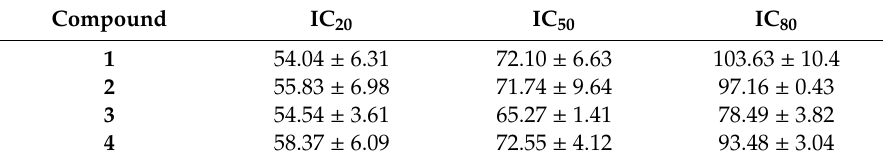
Figure 7. E ff ect of compounds 1 , 2 , 3 , and 4 , on cell proliferation in RAW 264.7 macrophage murine cells, after 72 h of treatment with assayed compounds in a wide range of concentration from 0 to 100 µ g / mL. Each point represents the mean value ± S.D. of at least two independent experiments performed in triplicate. IC 20 , IC 50 , and IC 80 are the concentrations required for growth inhibition of 20%, 50% and 80%. Table 1. Growth-inhibitory e ff ects of compounds 1 , 2 , 3 , and 4 on RAW 264.7 monocyte / macrophage murine